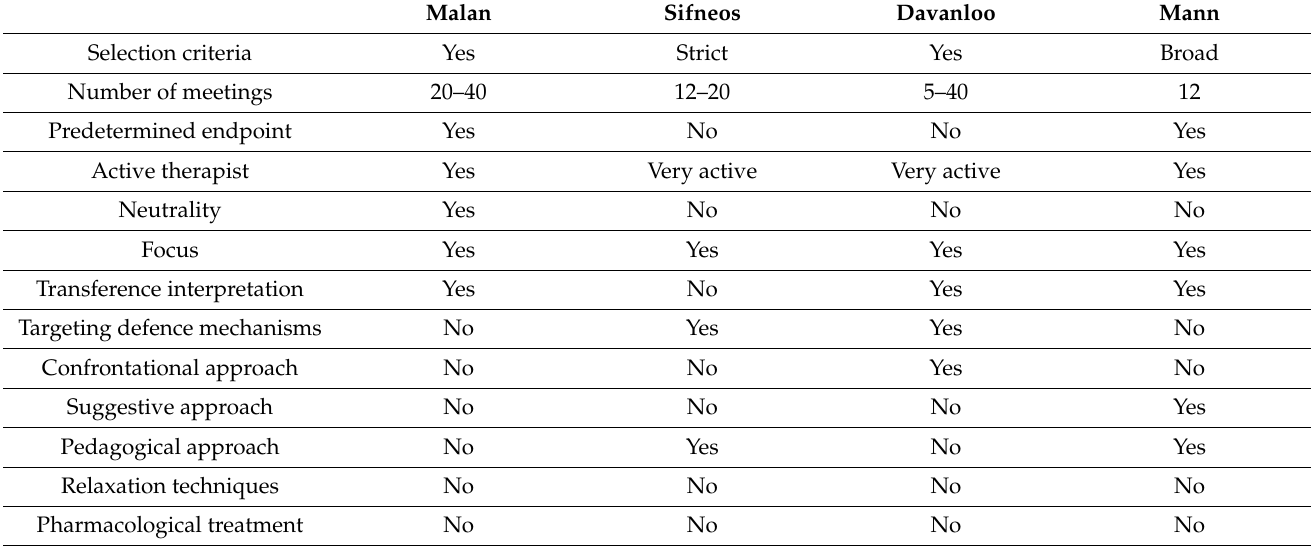
Table 1. Comparison of Short term psychodynamic therapy schools. Malan Sifneos Davanloo Mann